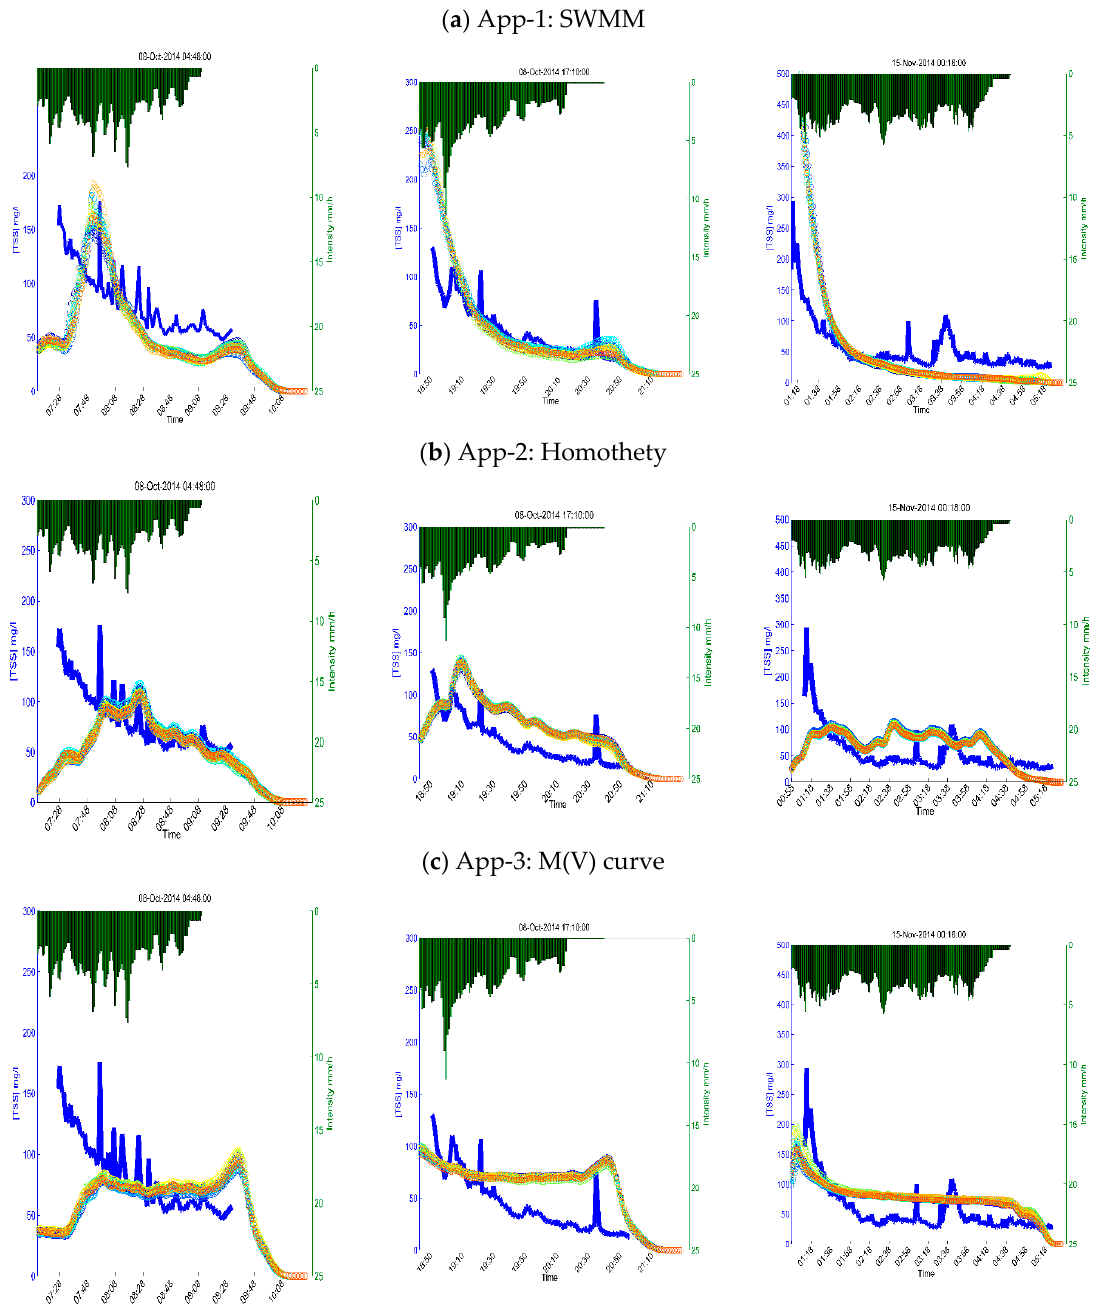
Figure 6. Best performance events based on TSS concentrations using C R ² and the C RMSE criteria for two rainfall events on 8 October, and one on 15 November simulated with ( a ) App-1: SWMM, ( b ) App-2: Homothety and ( c ) App-3: M(V) curve. The rainfall intensity is plotted on the upper part of the graphs. The solid blue lines represent the measured TSS concentrations. The rainbow-colored lines marked with circles represent the simulated TSS concentrations, where each color represents the TSS concentrations for one simulation.